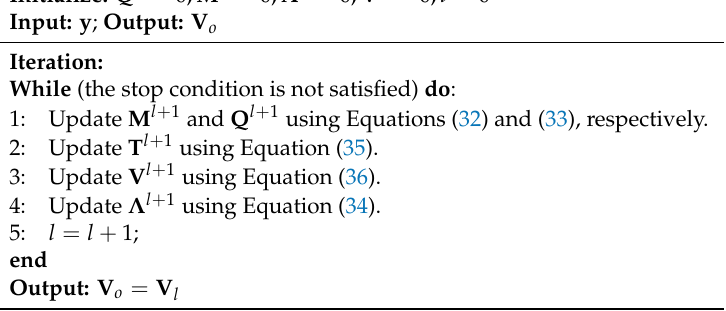
Table 1. The ADMM based BS-ANM